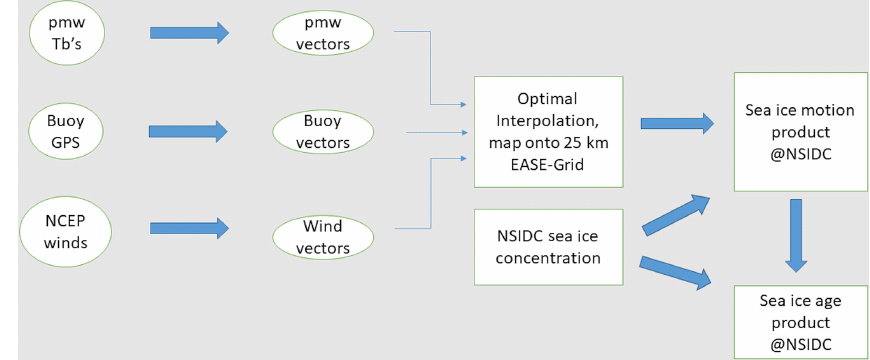
Figure 1. Flow chart for the production of the sea ice motion and age products. pmw is defined as passive microwave, and Tb’s is brightness